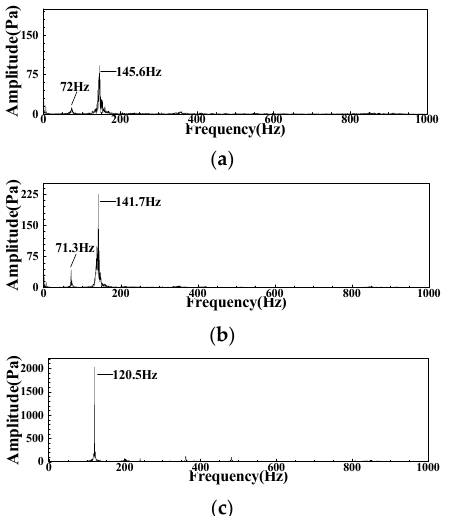
Figure 14. The spectrum of the DP signal under different operating conditions: ( a ) LA01; ( b ) LA02; ( c ) LA03.